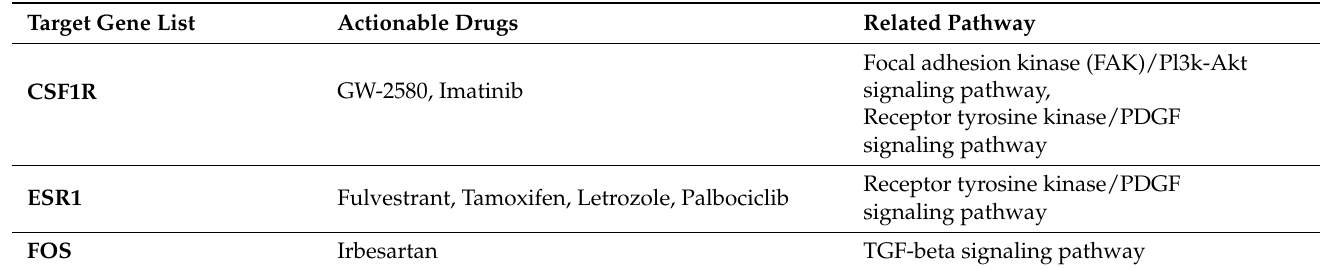
Table 2. List of 14 target candidate genes via gene-drugs network based on the CIViC database. Target Gene